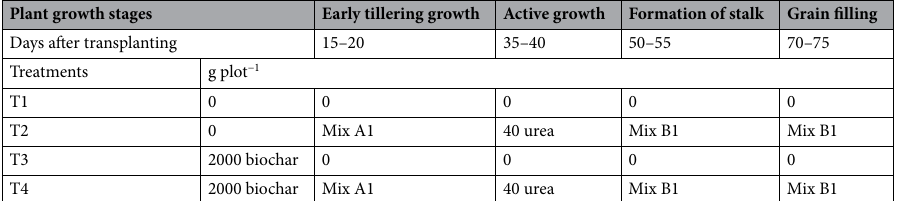
Additional substance of fertilizer 12:12:17:2MgO +